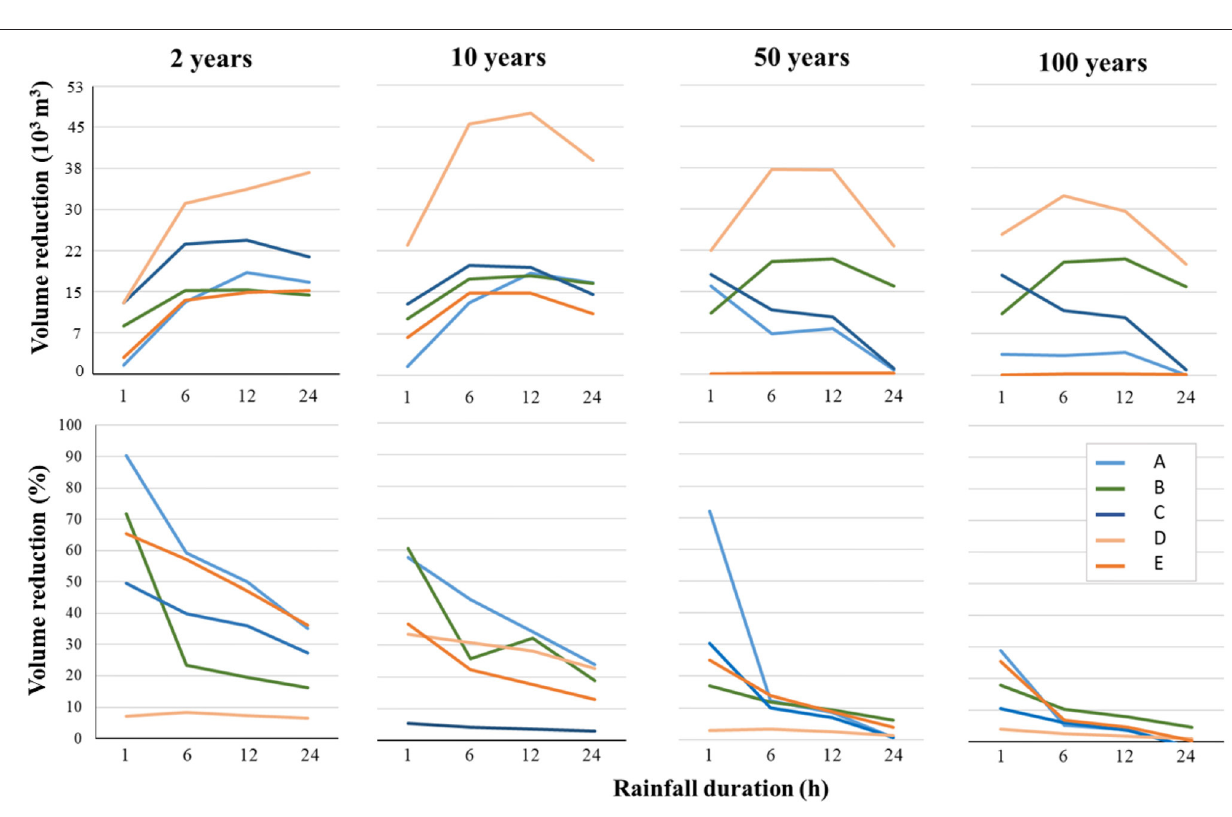
100 years return periods, and smaller reductions for the 10